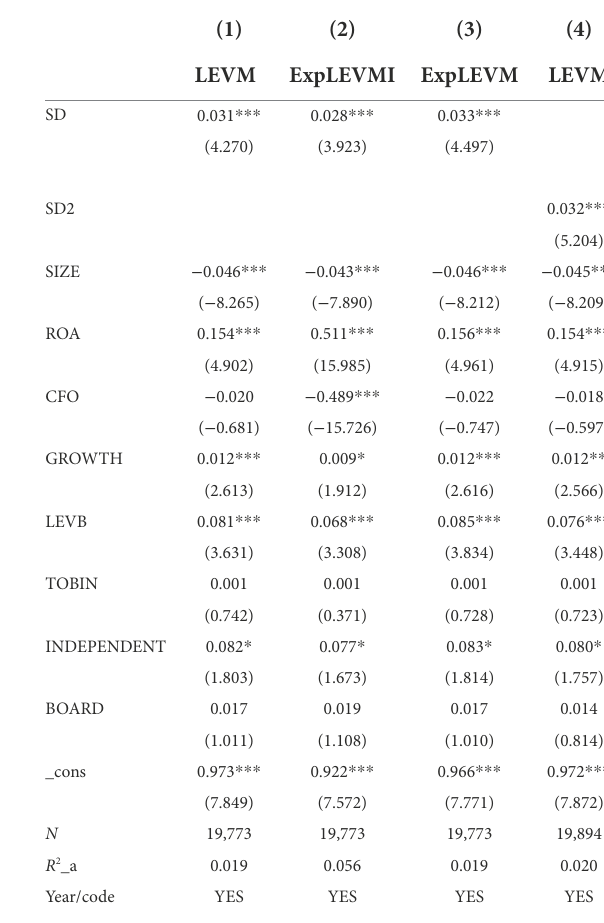
TABLE 11 Fixed effects test. TABLE 10 Instrumental variable method